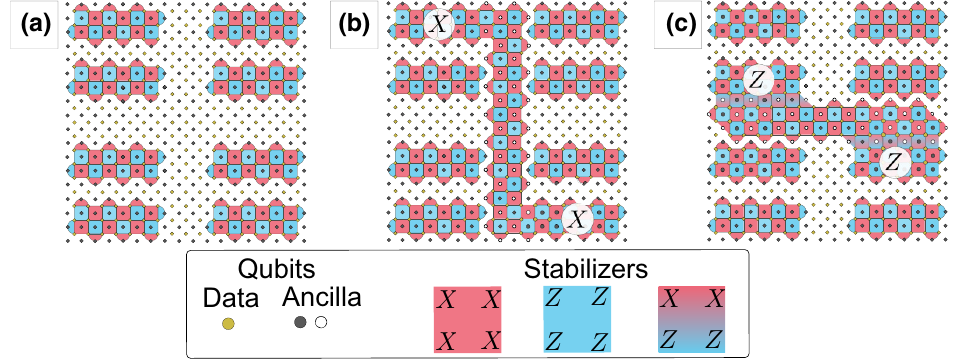
FIG. 2. A simple example of lattice surgery, illustrating the space overhead needed for routing. (a) Eight rectangular surface-code patches with some surrounding idle qubits that form the routing space. (b) The stabilizers needed to measure a logical X ⊗ X operator between the separated surface-code patches using the routing space between them. (c) Similarly, the stabilizers needed to measure a logical Z ⊗ Z operator between the separated surface-code patches using the available routing space. Stabilizers of mixed X and Z type are referred to as domain walls and are used to ensure that the d z distance of the surface code does not decrease when measuring Z -type logical Pauli operators via lattice surgery. White ancillas mark the stabilizers that directly contribute toward computing the parity of the X ⊗ X and Z ⊗ Z measurement